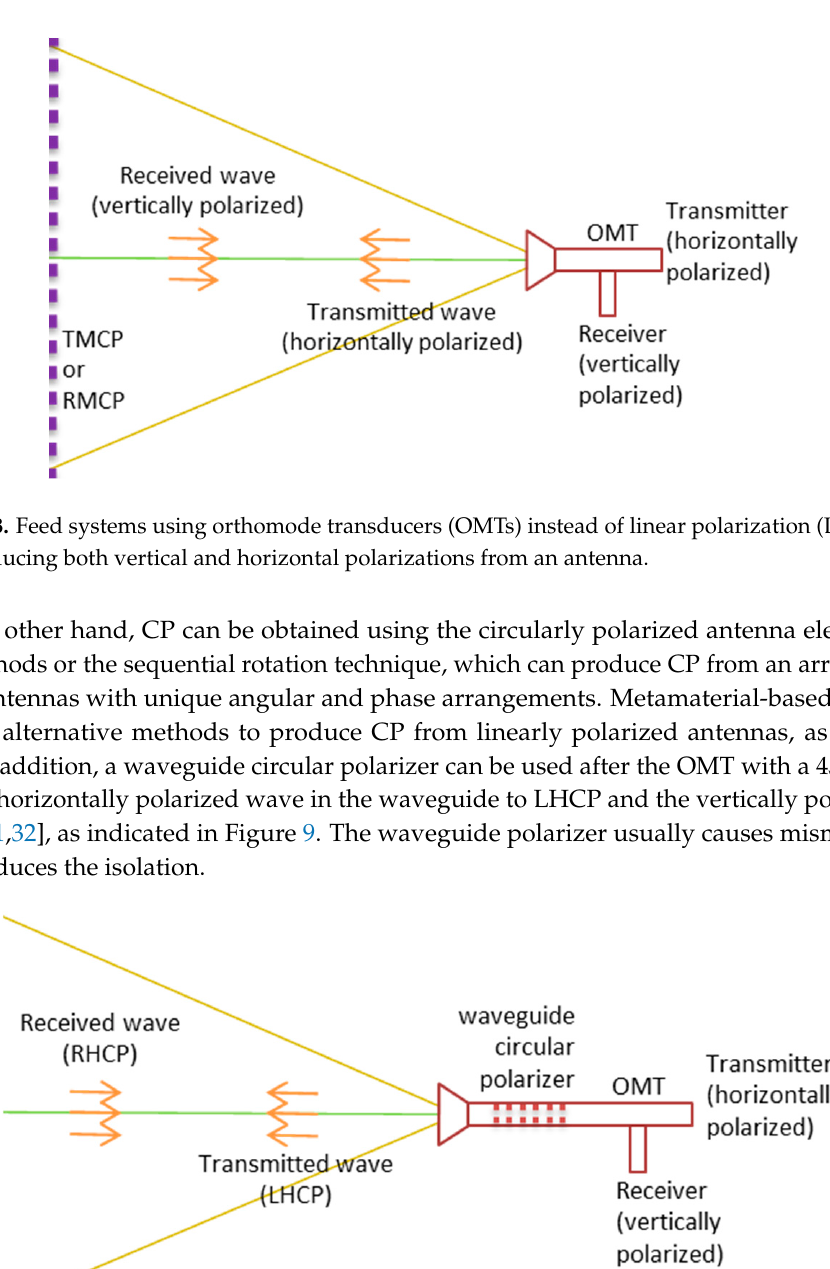
Figure 9. Feed systems using waveguide circular polarizers and OMTs instead of LP filters and TMCPs or RMCPs.